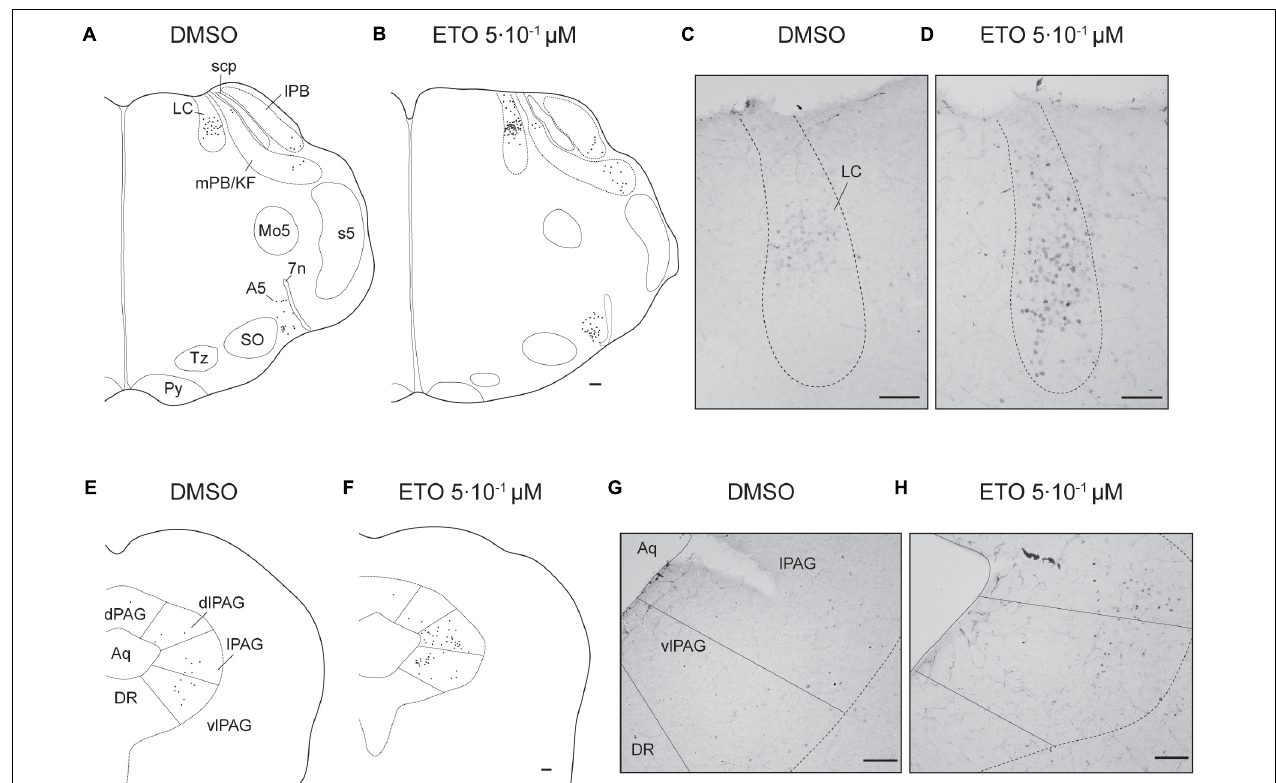
FIGURE 4 | Etonogestrel increases or enhances increase in prolonged metabolic acidosis-induced c-fos expression in supra-medullary respiratory-related areas. Drawings representing distribution of cells immunoreactive for c-FOS during prolonged metabolic acidosis (black points) in pons and in mesencephalon under DMSO (A,C) or 5 · 10 − 1 µ M etonogestrel (B,D) exposure. Photomicrographs illustrating metabolic acidosis-induced c-FOS immunoreactivity under DMSO (E,G) or 5 · 10 − 1 µ M etonogestrel (F,H) exposure in LC (E,F) , lPAG, and vlPAG (G,H) . Scale bar = 100 µ m. Abbreviations: A5 region (A5), aqueduct of Sylvius (Aq), dorsolateral part of the periaqueductal gray (dlPAG), dorsomedian part of the periaqueductal gray (dPAG), dorsal raphe nucleus (DR), etonogestrel (ETO), locus coeruleus (LC), lateral part of the periaqueductal gray (lPAG), lateral parabrachial nucleus (lPB), median raphe nucleus (MnR), medial